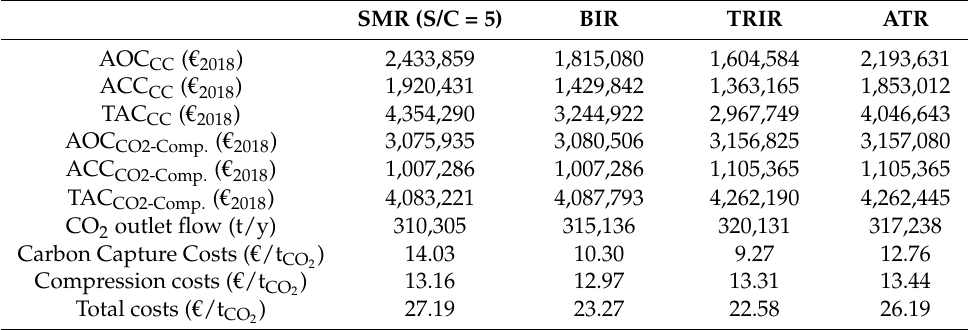
Table 17. Carbon capture costs for large scale raw